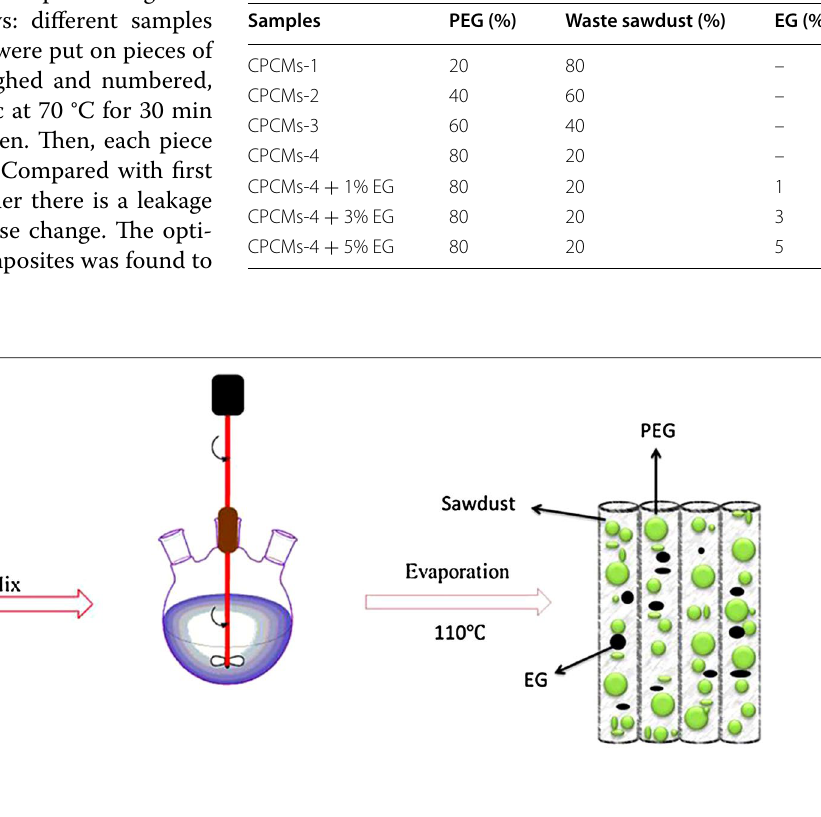
Fig. 1 Schematic preparation process for the composite phase change materials